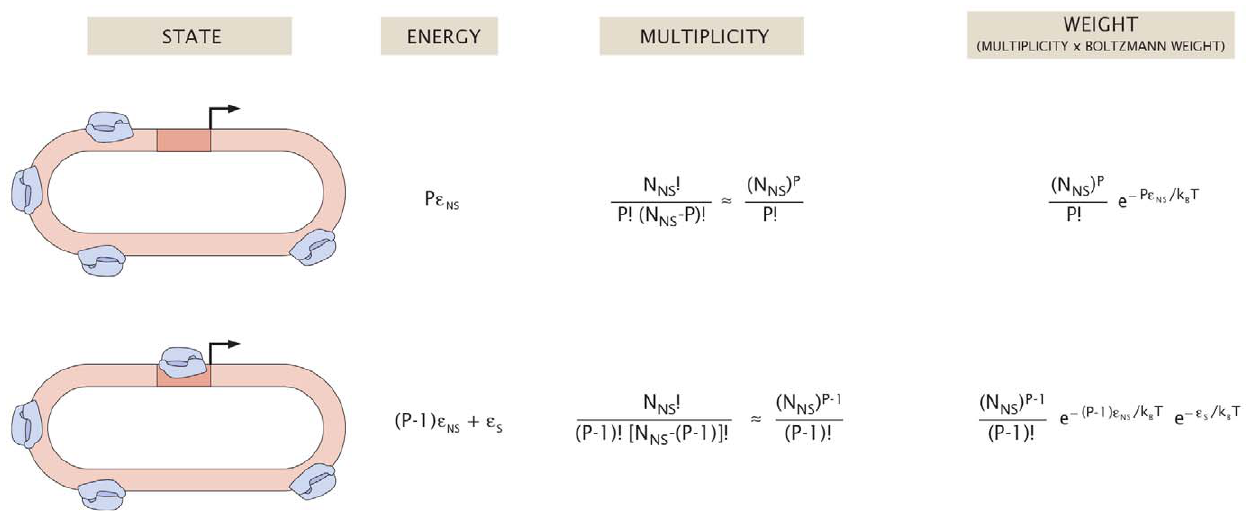
Figure 4. States and weights of the unregulated promoter. In the thermodynamic model, the promoter can be in one of two configurations: unoccupied by RNA polymerase (top) or occupied by RNA polymerase (bottom). The remaining polymerases are bound nonspecifically on the E. coli genome. The total energy is the sum of all the nonspecific binding energies and the specific energy of binding at the promoter (when occupied). The multiplicity factor accounts for the number of different ways of arranging polymerases on the genome.